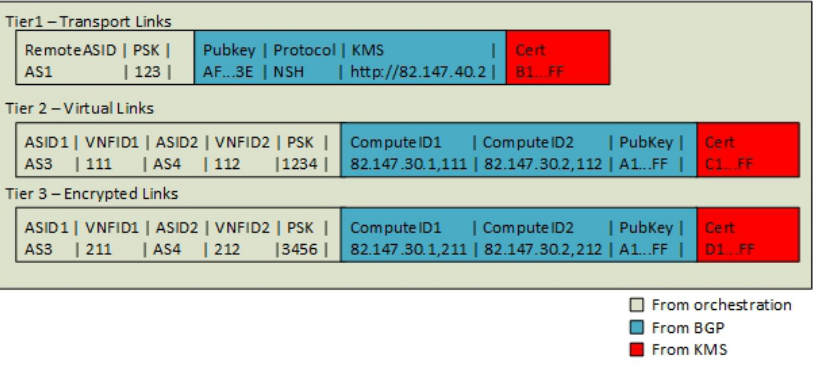
Figure 12. Key Manangement Service